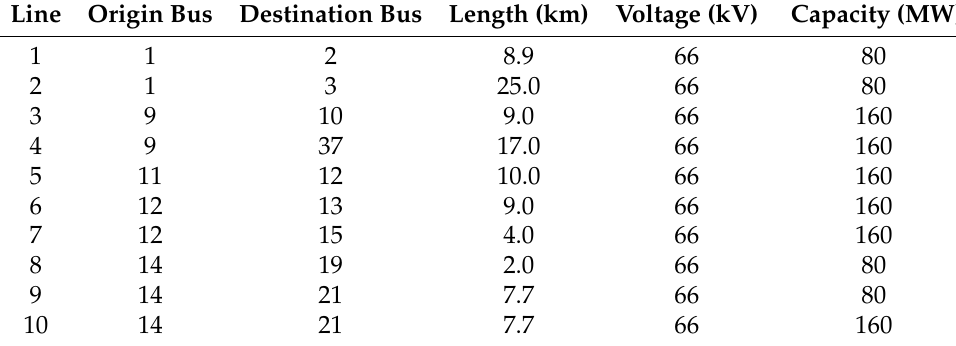
Table 6. Candidate